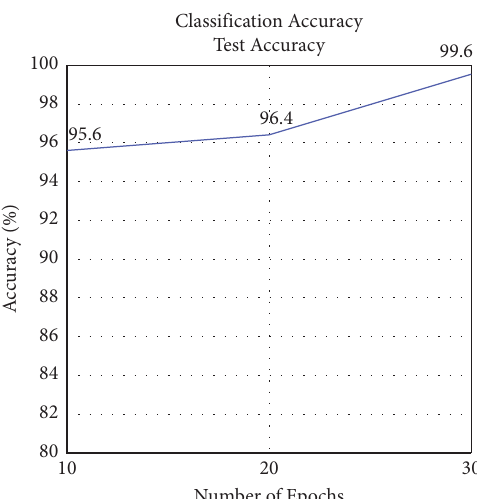
Figure 10: Classifcation accuracy of DenseNet using Adam optimizer.